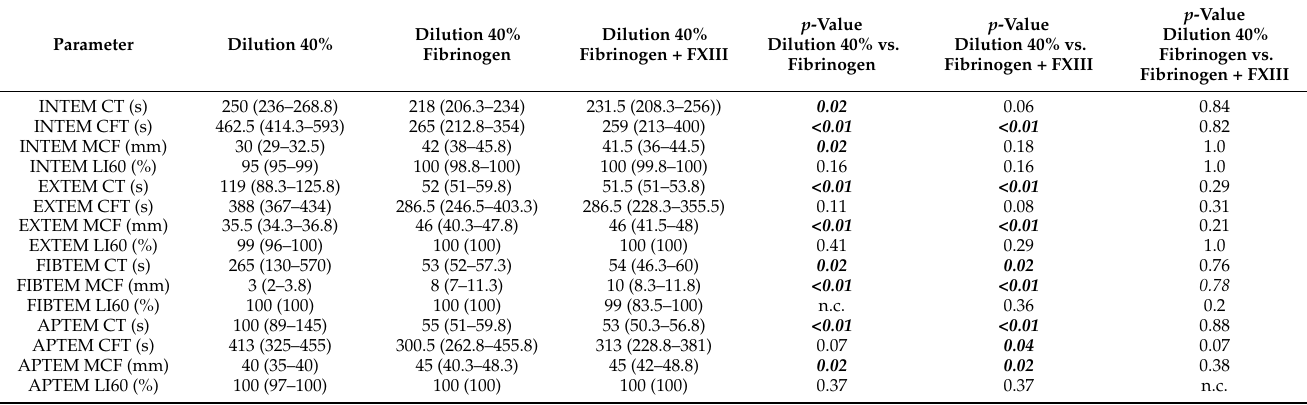
Table 3. Treatment of blood samples which were diluted by 40% and treated either with fibrinogen or combined fibrino-